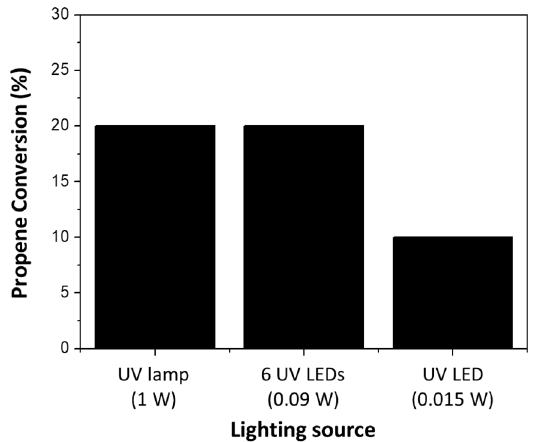
Figure 3. Study of the effect of the light source power in propene conversion using a UV lamp, 6 UV LEDs and 1 UV LED with 1W, 0.09 W and 0.015 W of power, respectively as light source.